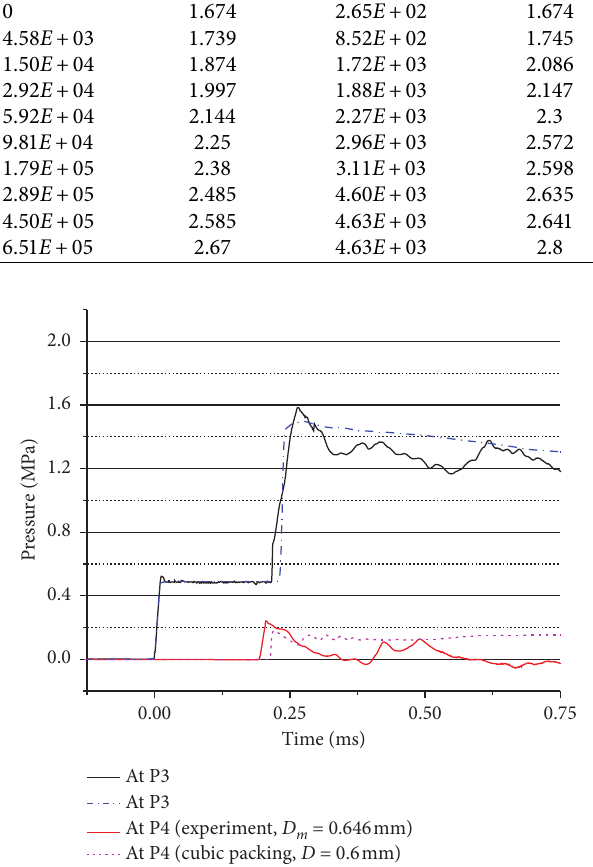
Figure 9: Shock wave structure comparison between simulation and experiment.